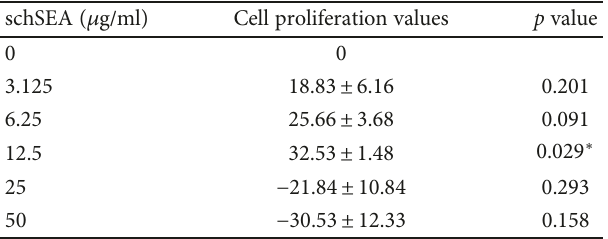
Cell proliferation values are means ± SD. Data are representative of three independent experiments ( n = 3 ). Statistical signi fi cance by Student ’ s t -test: ∗ p ≤ 0 05 .